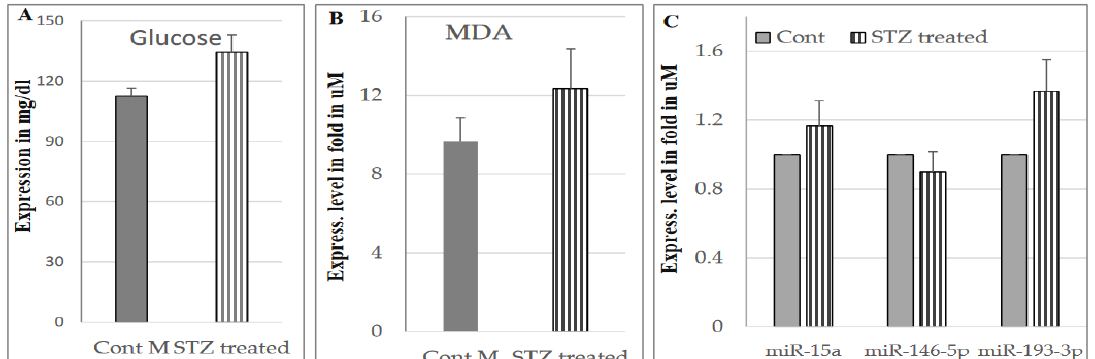
Figure 5. ( A ). Glucose level in blood of control and STZ-injected mice (60 mg/kg/bw), 28 h after injection of STZ. ( B ). LPO products (MDA) in brain of control and STZ-treated mice. ( C ). miRNAs injection of STZ. ( B ). LPO products (MDA) in brain of control and STZ‑treated mice. ( C ). miRNAs expression levels in brain tissue of control and STZ-treated mice. No statistical variation between expression levels in brain tissue of control and STZ‑treated mice. No statistical variation between group were found. Data are shown as mean ± SEM, n = 3 mice. group were found. Data are shown as mean ± SEM, n = 3